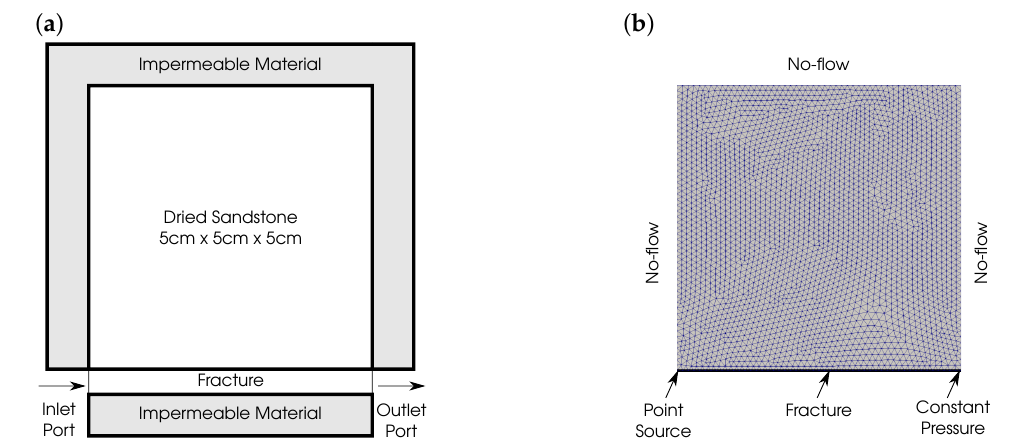
Figure 5. Model CUBE: ( a ) boundary conditions and ( b ) mixed-dimensional finite element mesh. The rock sample was dried in a vacuum oven. Then, water was continuously injected through the injection port on the bottom left of the model at a constant flow rate of 0.1 cc/min. Excess fluid was collected from the production port in the model’s bottom right corner. To simulate the imbibition experiment, a mixed-dimensional triangular FE mesh was created (Figure 5b). Additional line elements along the bottom side of the block represent the